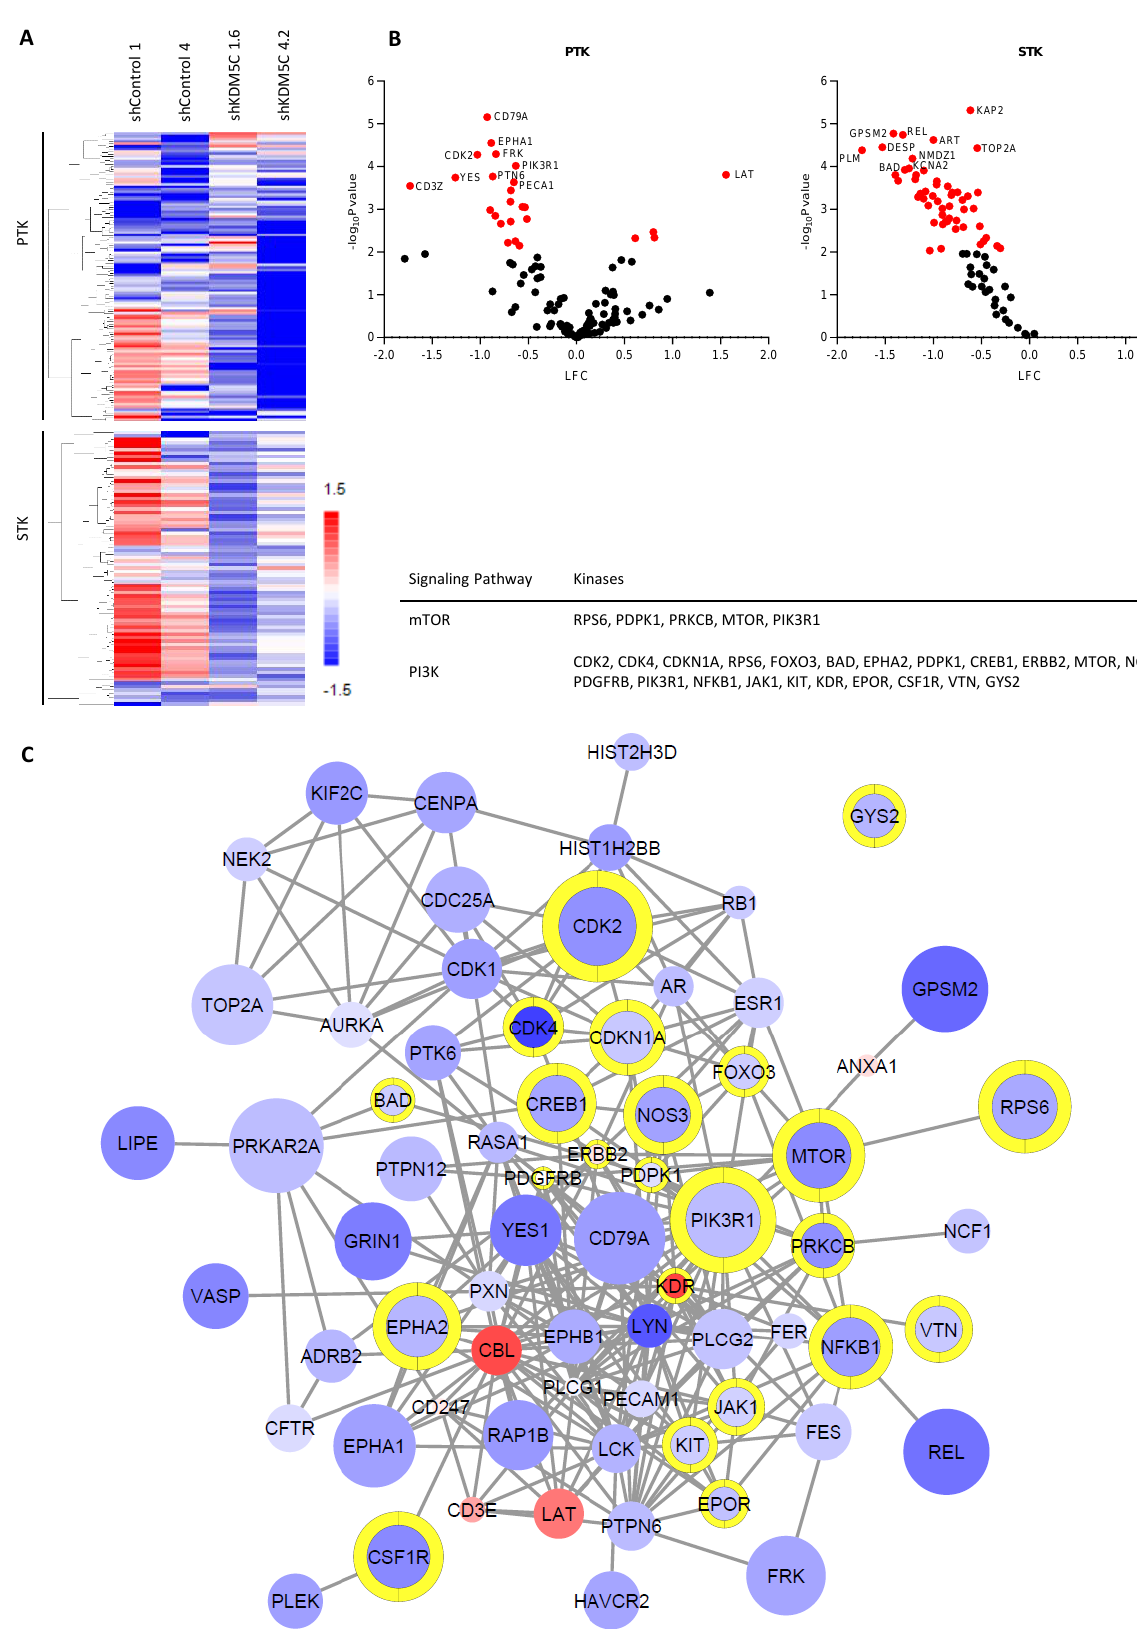
Figure 6. Kinase activity in KDM5C knockdown cells compared to control cells. ( A ) Clustered heat map of increased and decreased phosphorylation of Tyr (PTK, top) and Ser/Thr (STK, bottom) bait peptides in control cells and stabile knockdown of KDM5C; ( B ) Volcano plots of the bait peptide